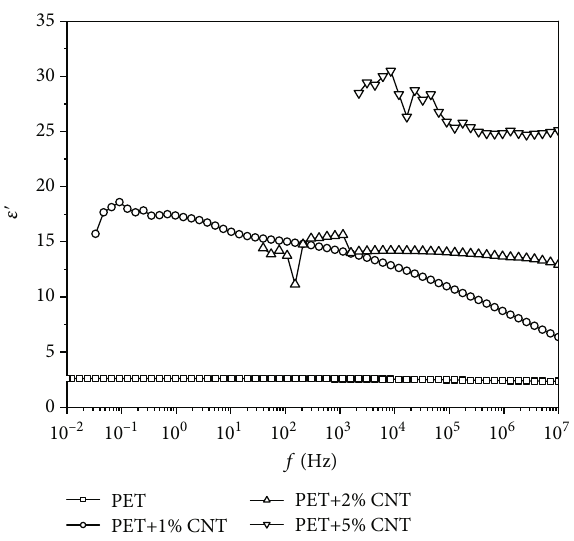
Figure 4: PET/CNT nanocomposite dielectric permittivity ε ′ .